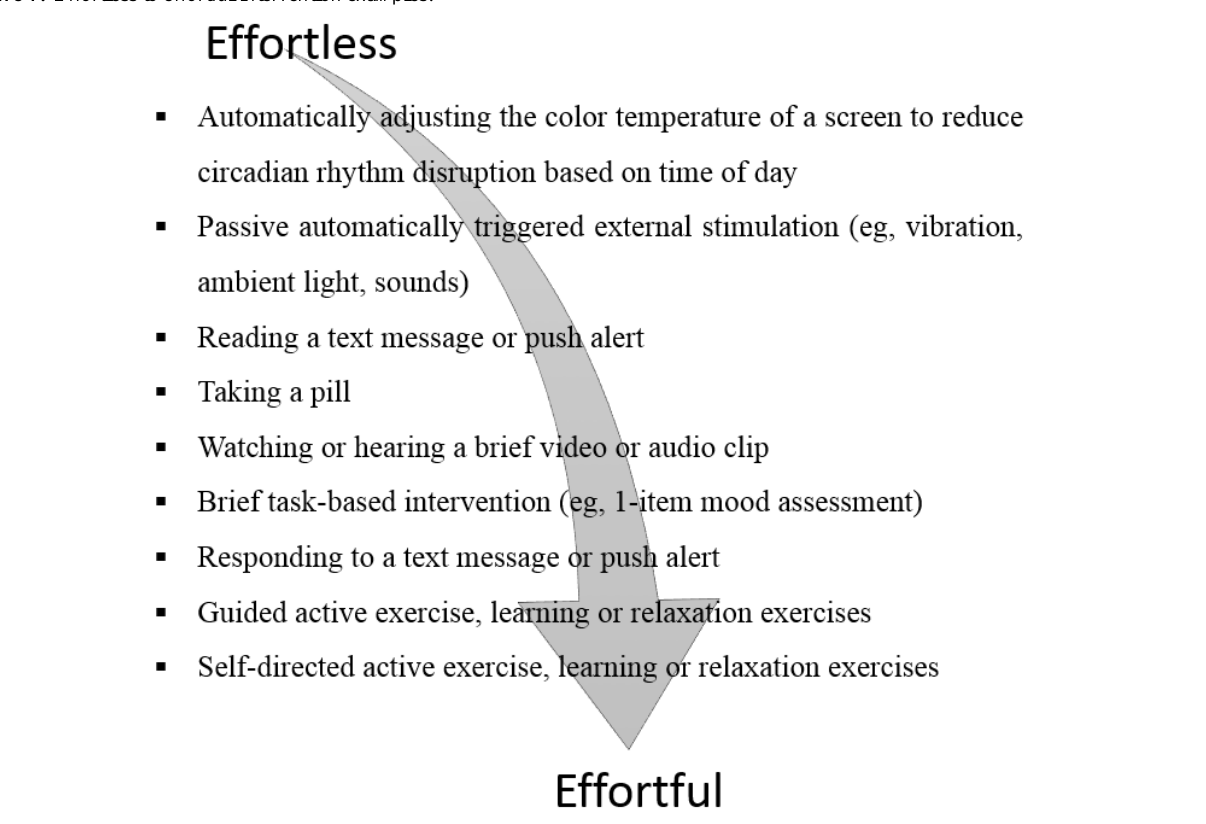
Figure 1. Effortless to effortful intervention